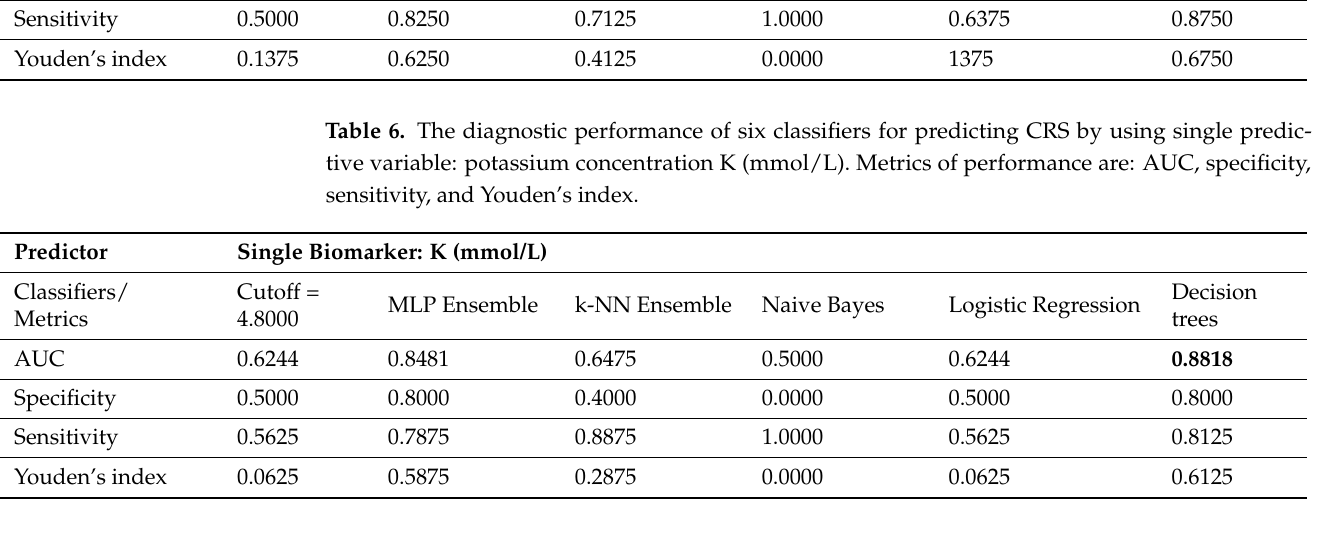
Table 7. The diagnostic performance of five classifiers for predicting CRS by using combination of four predictors EPI cysC (mL/min/1.73 m 2 ), NTproBNP (pg/mL), Na (mmol/L), and K (mmol/L). Metrics of performance are: specificity, sensitivity, and Youden’s